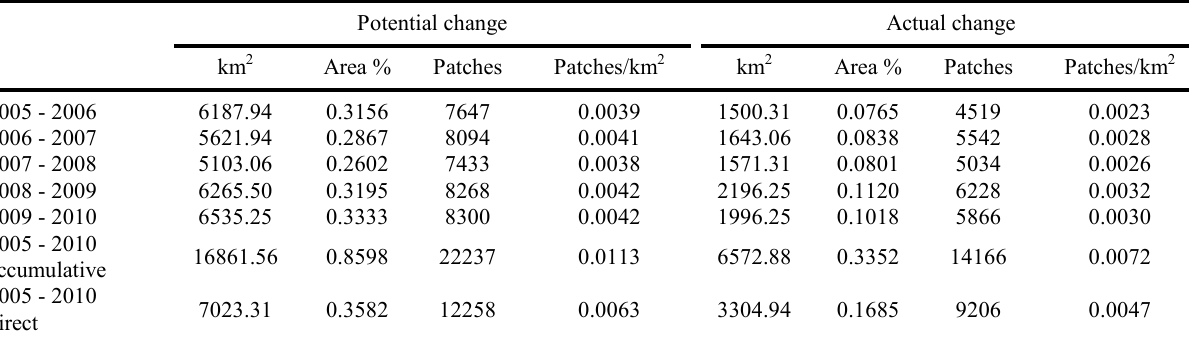
Table 2. Area and patches for potential and actual change of MODIS data at the national scale.